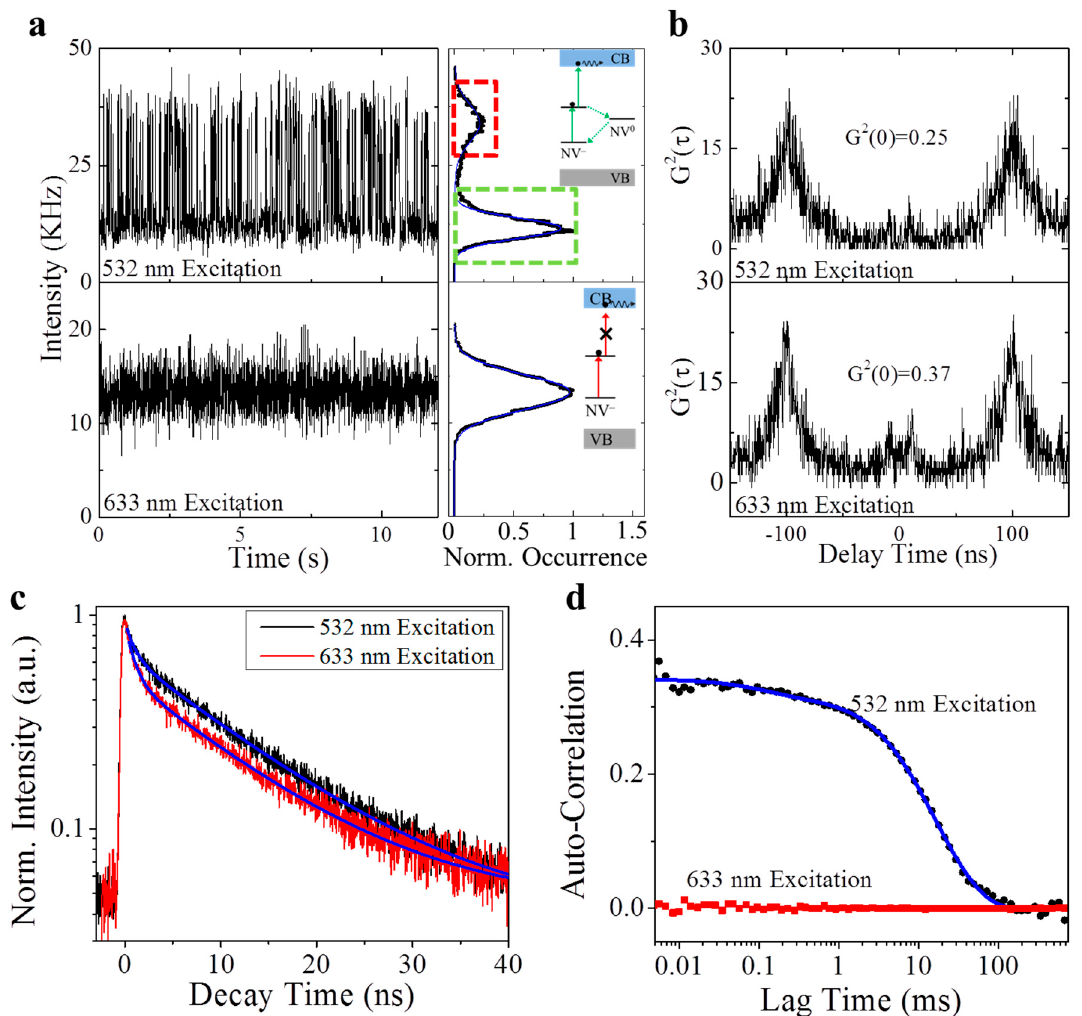
Figure 3. Typical time-resolved spectra of individual NV center under the illumination of 532 nm and 633 nm laser beams. ( a ) A 12-s fragment of a 60 s time trajectory of a single NV center excited by 532 nm laser (upper) and 633 nm laser (lower), with corresponding histograms on the right. The inset is the theoretical explanation; photonionization happens under 532 nm excitation, and stops because the photon energy is smaller than the gap between the excited state and the conduction band. ( b ) The 2nd-order correlation measurement shows the single photon emission signature from the NV center under different excitations. ( c ) Time-correlated single photon counting (TCSPC) decay curves of the fluorescence emission from the NV center under the excitation of 532 nm and 633 nm laser lines suggest a similar lifetime of excited state. ( d ) The auto-correlation calculation of the time trajectory in ( a ) indicates different dark-state dynamics under the illumination of 532 nm and 633 nm laser beams. A two-component mode is required to fit the ACF curve under green illumination, while no dynamics is observed under red illumination.